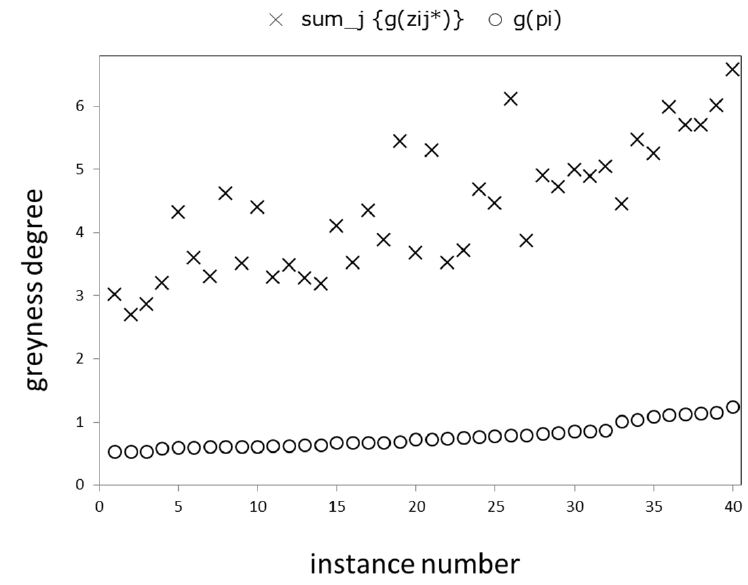
Figure 3. Greyness degree results for convex combination.